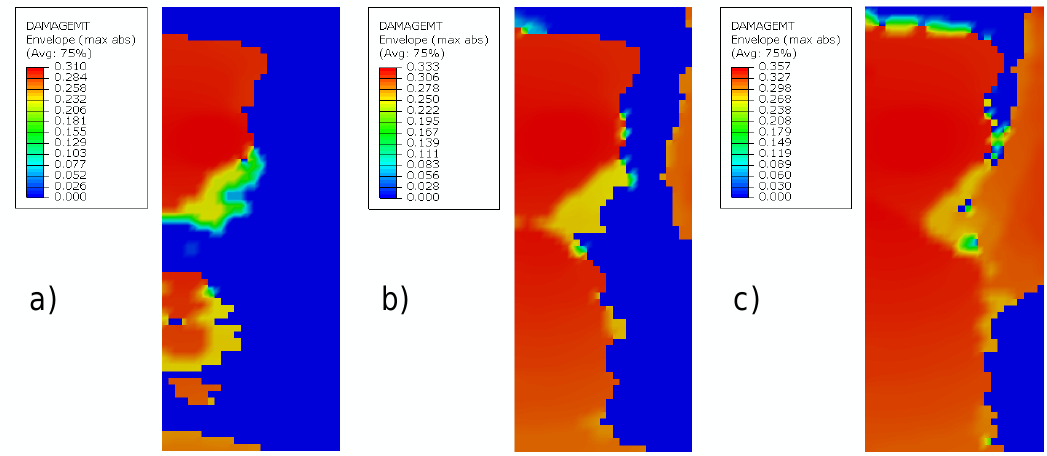
Figure 9. Matrix-tension damages of the composite plate with the root and one side edge clamped boundary condition under different impact velocities: ( a ) 100 m/s, ( b ) 120 m/s, and ( c ) 140 m/s.